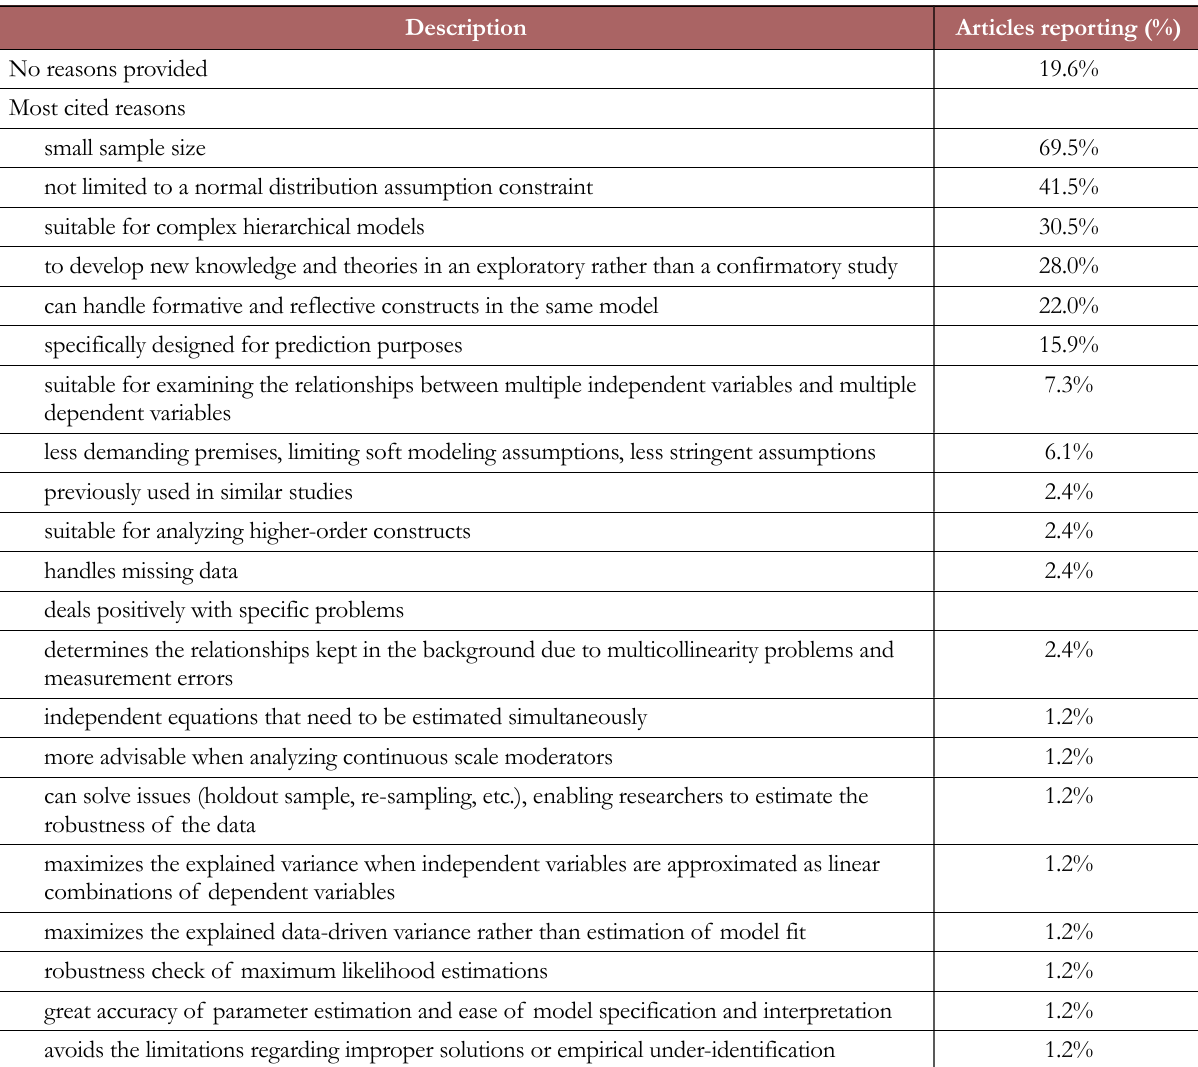
Table 4. Reasons given for using PLS (N=102)